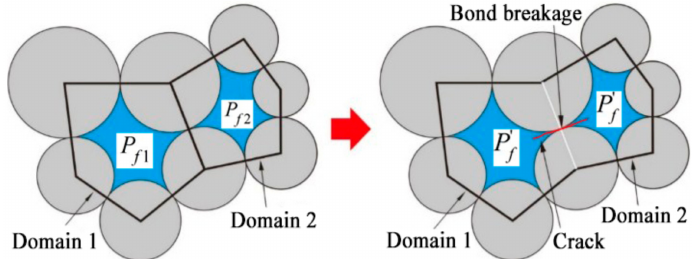
Figure 3. The balance of fluid pressure in two related domains after bond breakage (modified from Zhou et al.